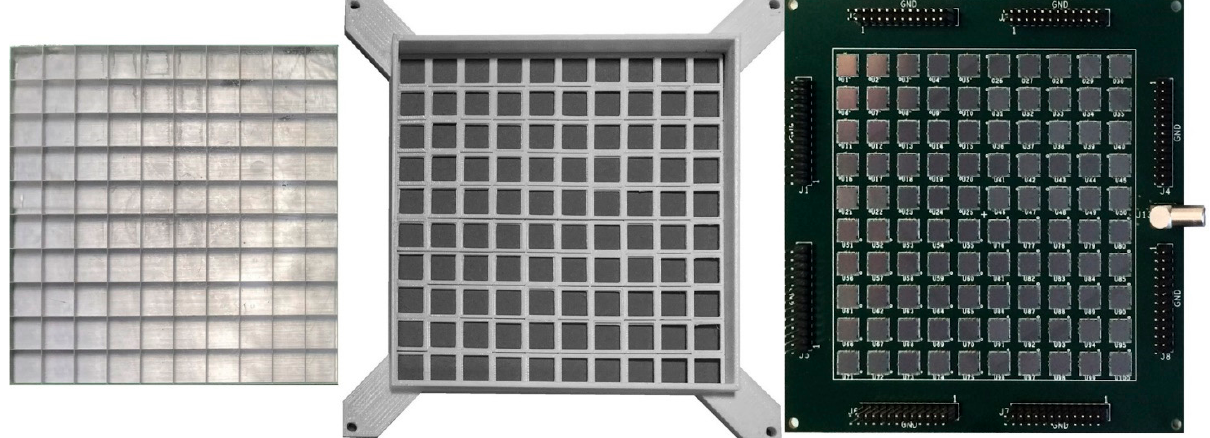
Figure 3. The detector components, from left to right: the scintillator array, the coupling frame mask and the SiPM array. On the four sides of the SiPM array board, the eight 26-pin dual header plugs for the output signals are visible, along with the bias voltage LEMO connector shown on the righthand side.